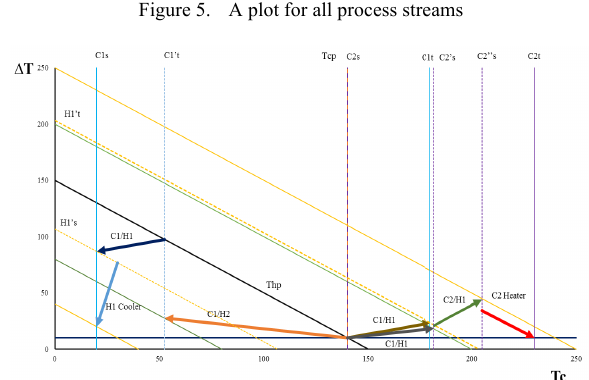
Figure 5. A plot for all process streams